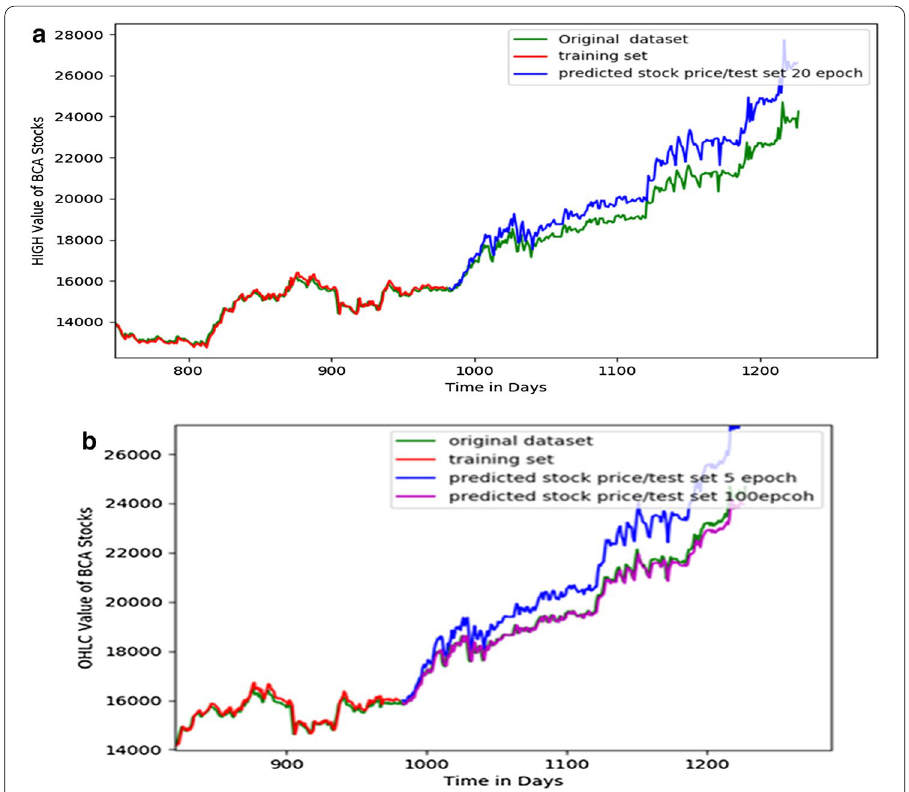
Fig. 9 Result of prediction of high price using 20 epochs ( a ) and OHLC price using 5 and 100 epochs. Prediction using 100 epochs is better than 5 epochs ( b )